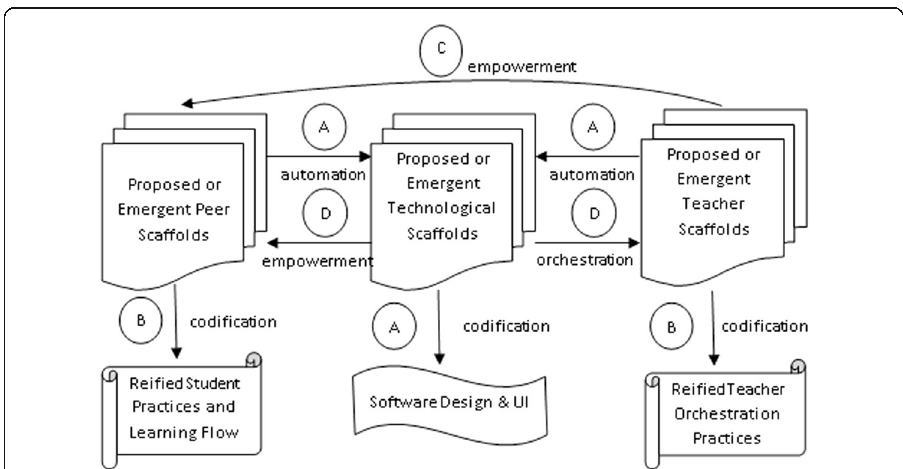
Fig. 2 The distributed scaffolding design